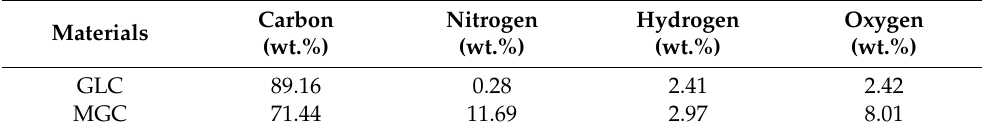
Figure 3. X-ray photoelectron spectroscopy (XPS) survey scan of ( a ) GLC and ( b ) MGC, ( c ) high-resolution N 1s spectrum of MGC, and ( d ) adsorption test of GLC and MGC in 2.5 mM Li 2 S 6 solution. Table 2. The elemental weight percentage of elemental analysis.